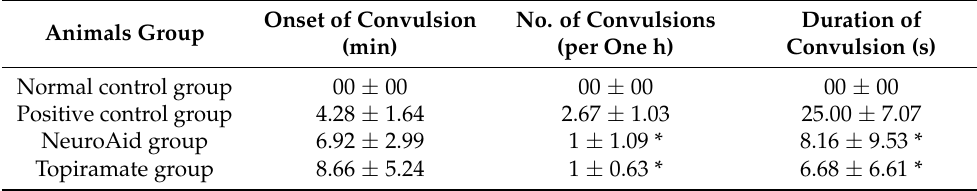
Table 1. Effects of NeuroAid on convulsion parameters induced by strychnine.